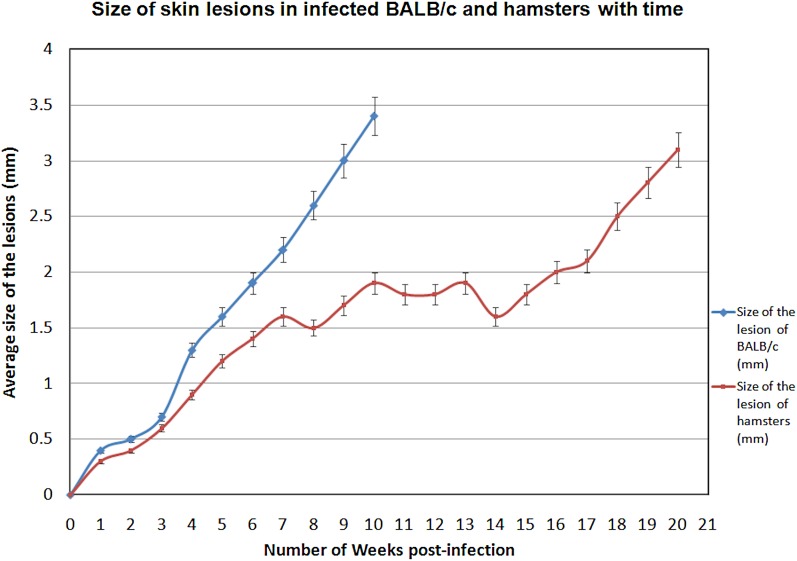
Size of skin lesions in infected BALB/c and hamsters against time. Animals were infected with L. donovani-SL promastigotes intra-dermally in the ear pinna and lesion appearance and progression were monitored weekly for a period of 10 weeks for BALB/c and 20 weeks for hamsters. Data shown indicate the mean lesion size ± s.d. in each experimental group.